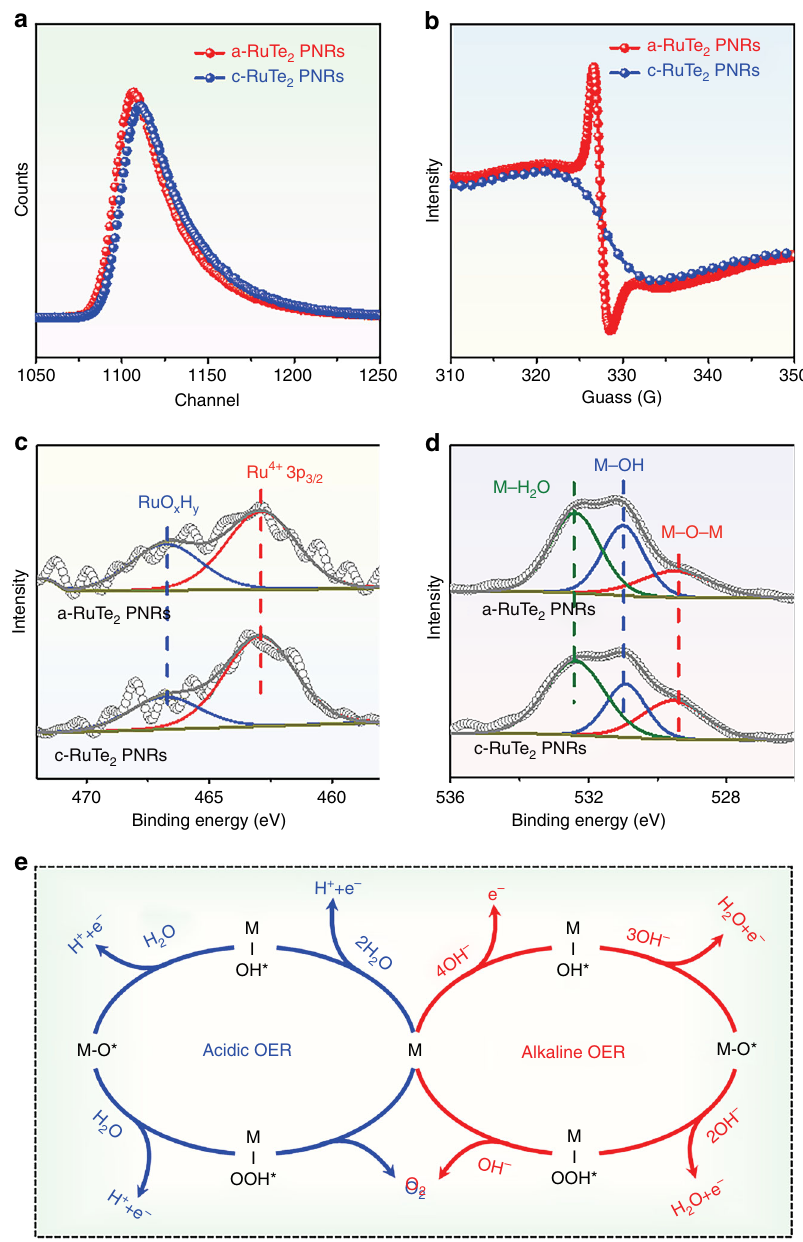
Fig. 8 Mechanism investigations. a Positron lifetime spectra, b ESR spectra, c Ru 3p, and d O 1s XPS spectra of a-RuTe 2 PNRs and c-RuTe 2 PNRs. e Schematic illustration of the OER process under acidic and alkaline